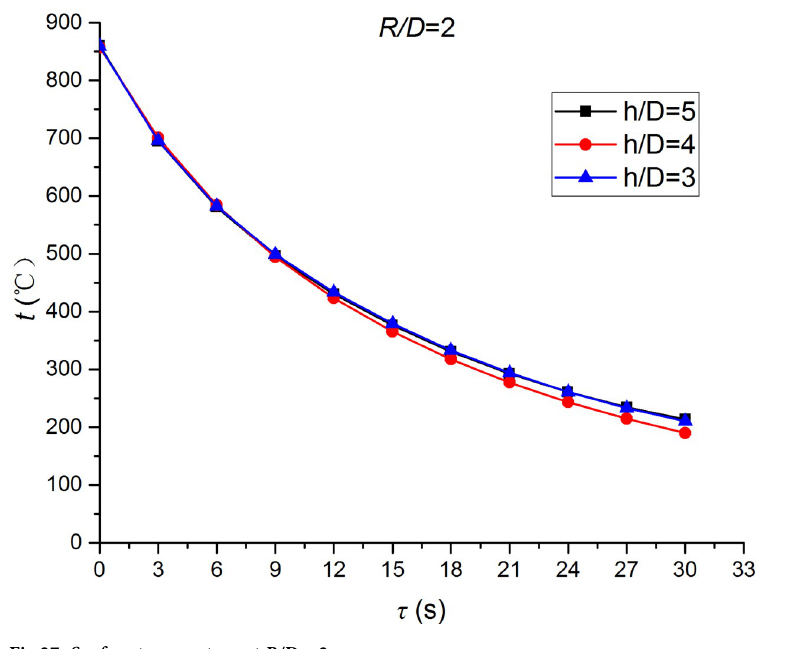
Fig 27. Surface temperature at R/D =